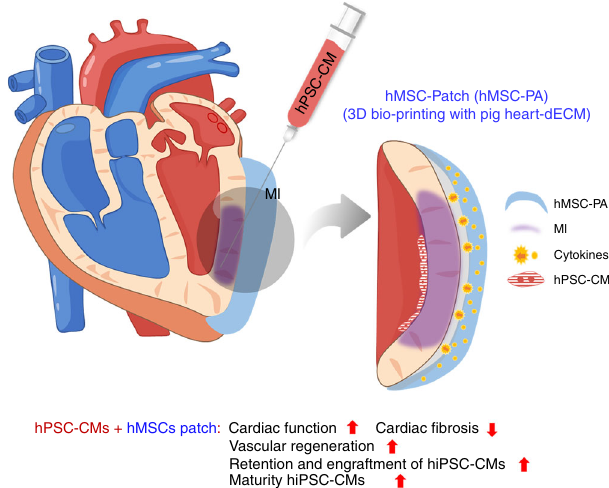
Fig. 8 Schematic diagram of the underlying mechanism of dual treatment approach of hPSC-CMs and